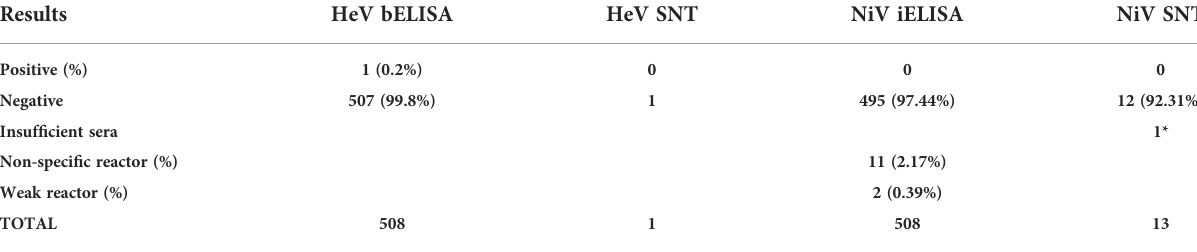
TABLE 3 Serology results for pigs in the screening (HeV bELISA and NiV iELISA) and con fi rmatory (HeV SNT and NiV SNT) assays. Results